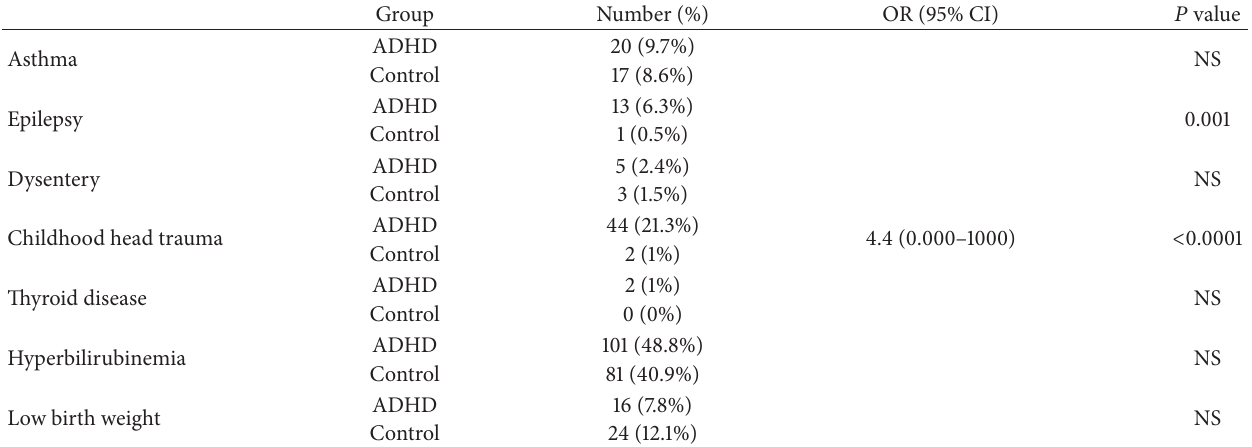
Table 3: Neonatal and childhood related risk factors for ADHD among case and control